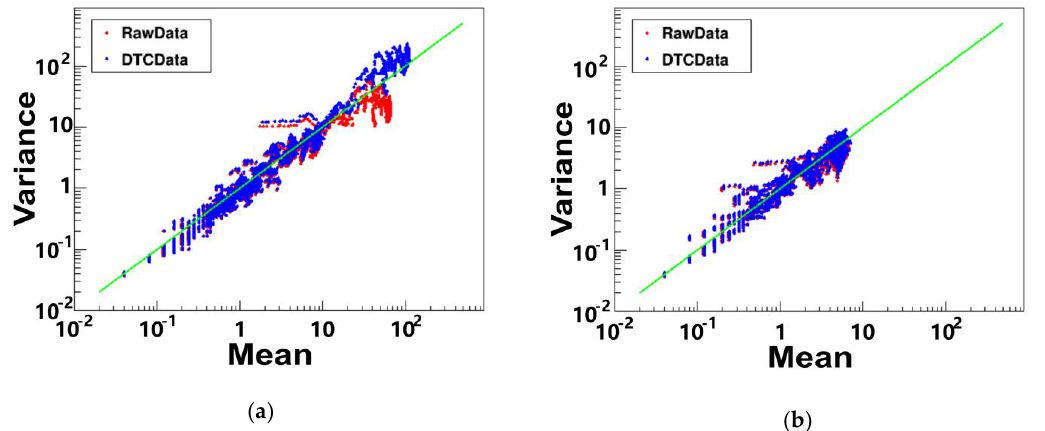
10 of 16 Figure 8. The number statistics of non-zero data points in a probing profile with different preset discriminator levels of the Licel transient recorder TR40-160 in the ultraviolet elastic scanning lidar. 4.3. Evaluation of the linear working range of the PMT With a power supply providing high voltage up to kilovolts, the PMT can work and convert the light pulse to the electrical signal. Meanwhile, the high voltage must be set in a linear working